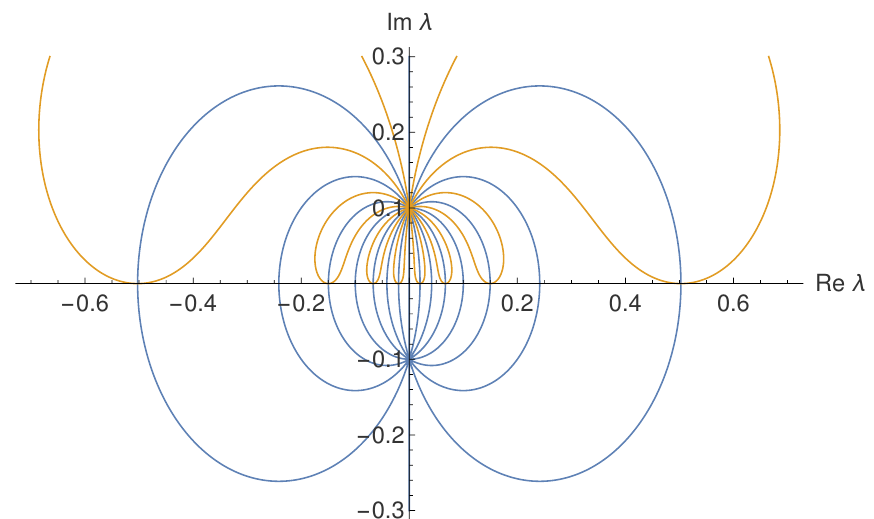
Figure 2: Contour plot of the function f (cid:34) for N = 16, (cid:34) = 0.1. Blue contours Im f (cid:34) = 0, orange contours Re f (cid:34) = − 1. We see 8 = N / 2 points λ ) = − which f (cid:34) ( λ j